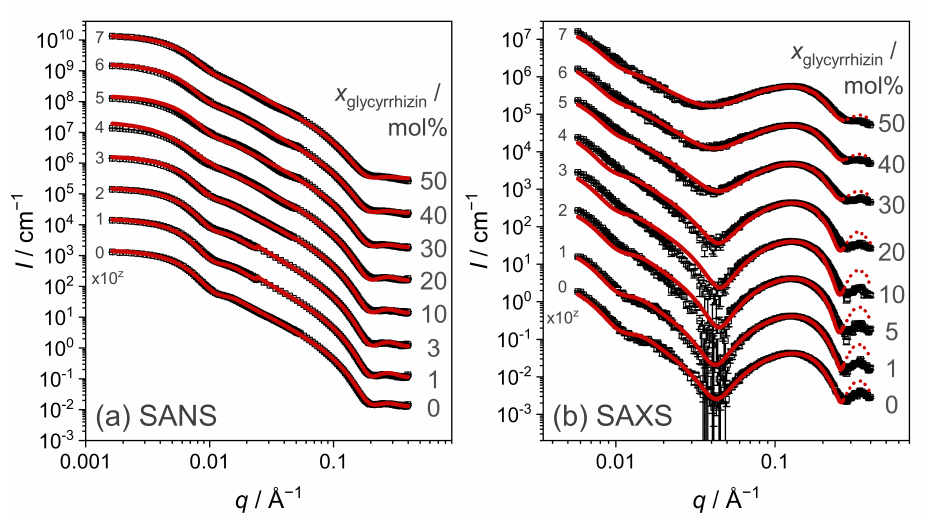
Figure 4. Comparison of ( a ) SANS and ( b ) SAXS data for samples with different x glycyrrhizin in D 2 O buffer. x glycyrrhizin is denoted by numbers on the right. Solid lines are approximations with the CMS model from SASView [59]. For better readability, the data are scaled by different multiples of 10 (exponent z ) indicated by the numbers on the left side of the curves. Dotted lines in panel ( b ) are extrapolations of the CMS fits beyond the fit